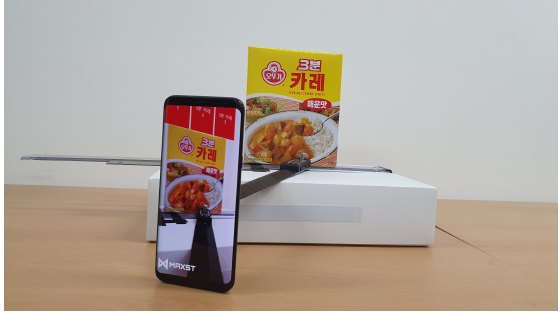
Figure 3. Setup to measure minimum recognizable viewing